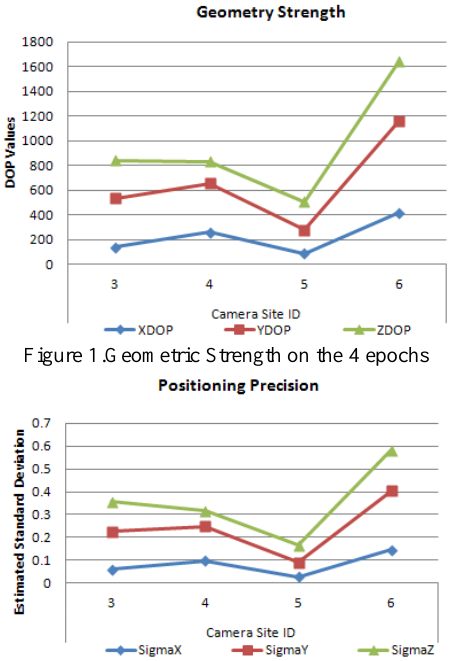
Figure 1.Geometric Strength on the 4 epochs